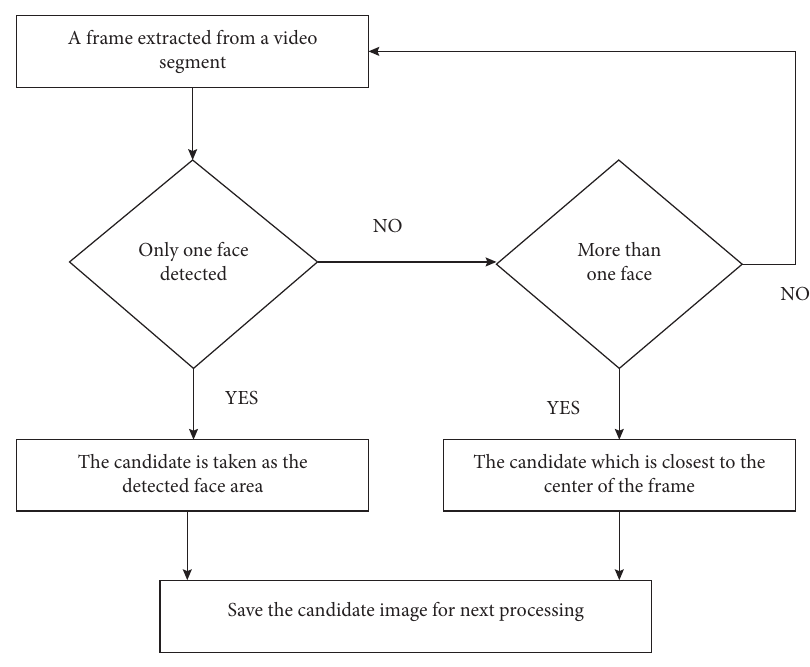
Figure 3: Flow diagram of the face detector.